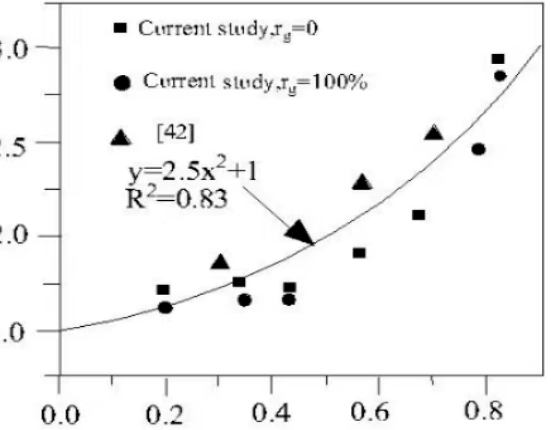
Figure 5. Relationship between the steel fiber content in steel fiber recycled concrete and the flexural strength [61].